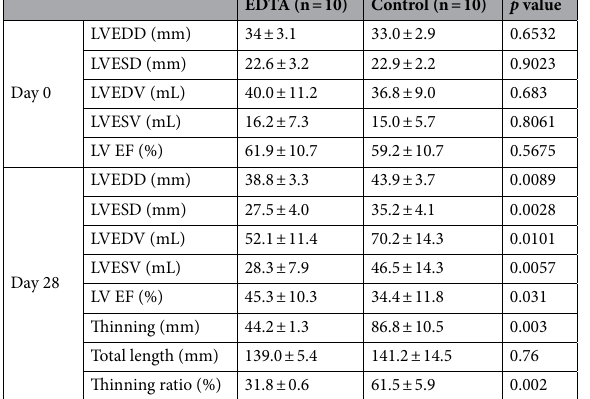
Table 1. Echocardiographic parameters of the EDTA and control groups. LVEDD left ventricular end- diastolic diameter, LVESD left ventricular end-systolic diameter, LVEDV LV end-diastolic volume, LVESV left ventricular end-systolic volume, LVEF left ventricular ejection fraction by volumetric